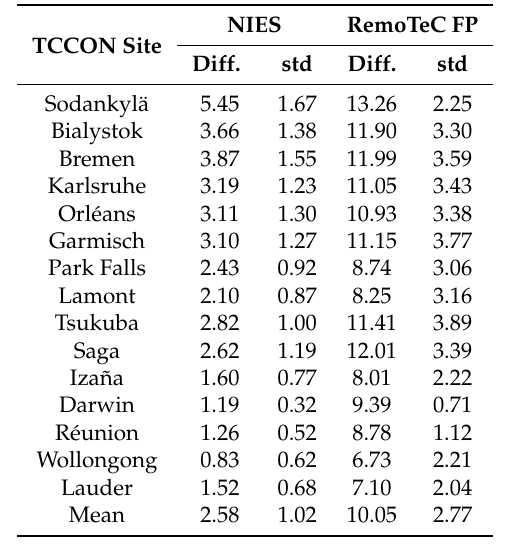
Table A2. Average difference (Diff.) between non-corrected GOSAT XCH 4 and the averaging-kernel- corrected, and its standard deviation (std). The difference is calculated from GOSAT XCH 4 (corrected)– GOSAT XCH 4 (retrieved). All units are in